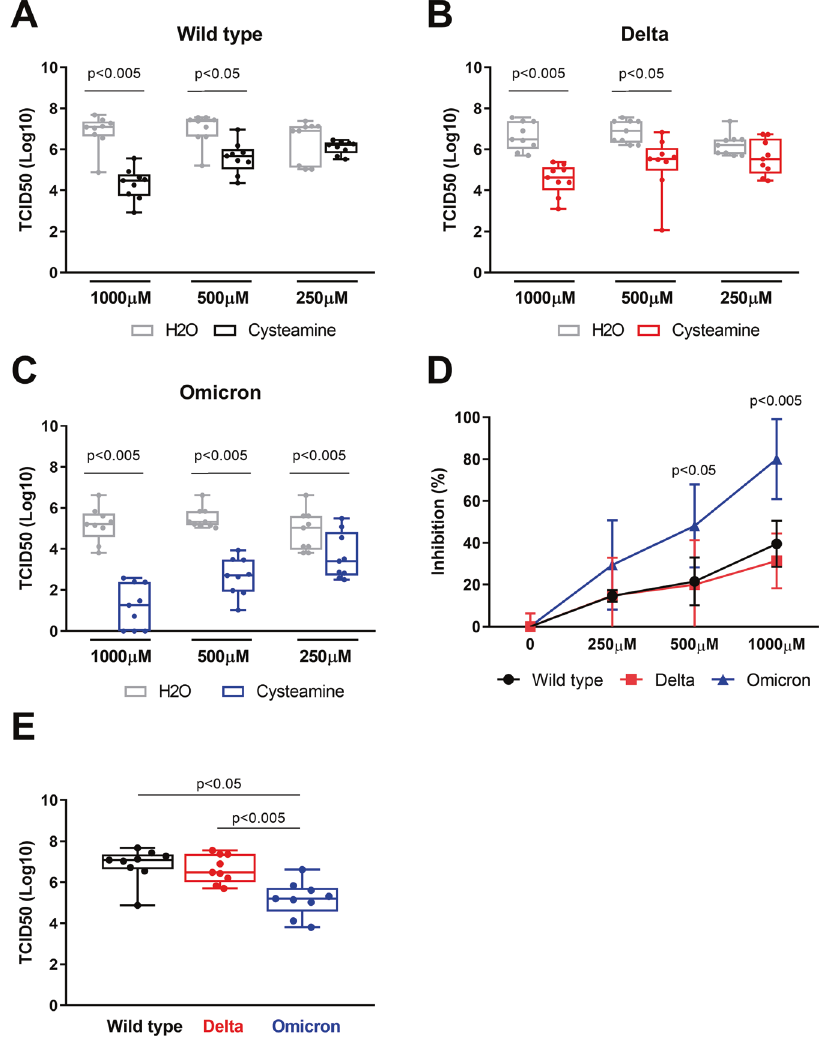
± S.D. ( n = 9) of three independent experiments performed in